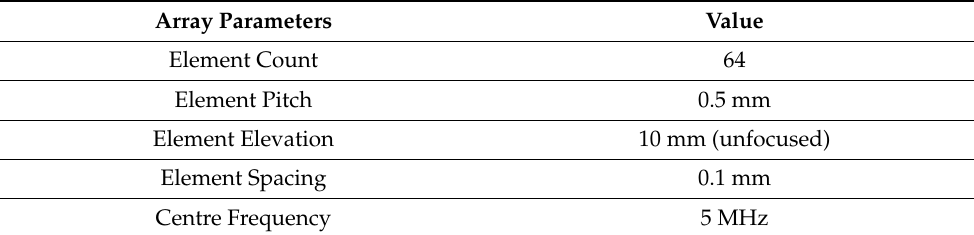
Table 3. PAUT parameters.